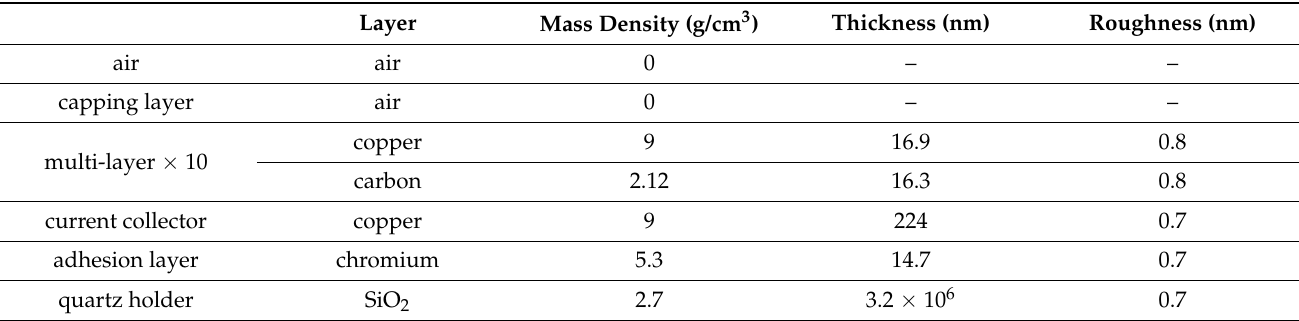
Table 3. Parameters used for the simulation of the reflectivity pattern presented in Figure 10c, using the Parratt32 code, i.e., obtained for the C/Cu ML after 542 cycles, after washing with PC and acetonitrile, and after air exposure for 15